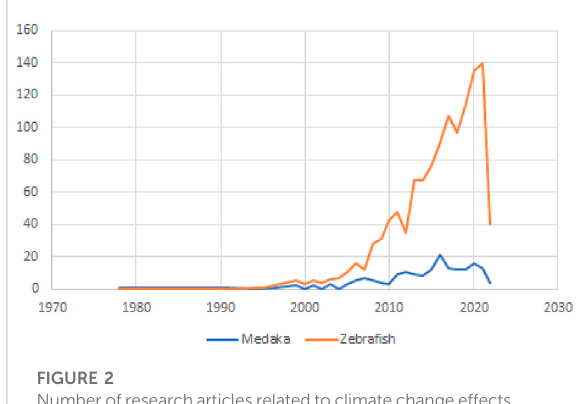
FIGURE 2 Numberofresearcharticles relatedto climatechangeeffects on Medaka and/or Zebra fi sh published annually since